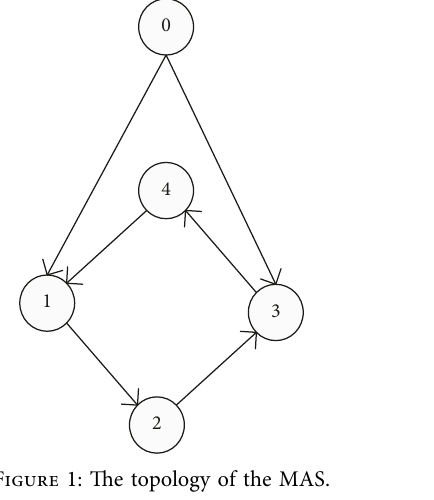
Figure 1: The topology of the MAS.